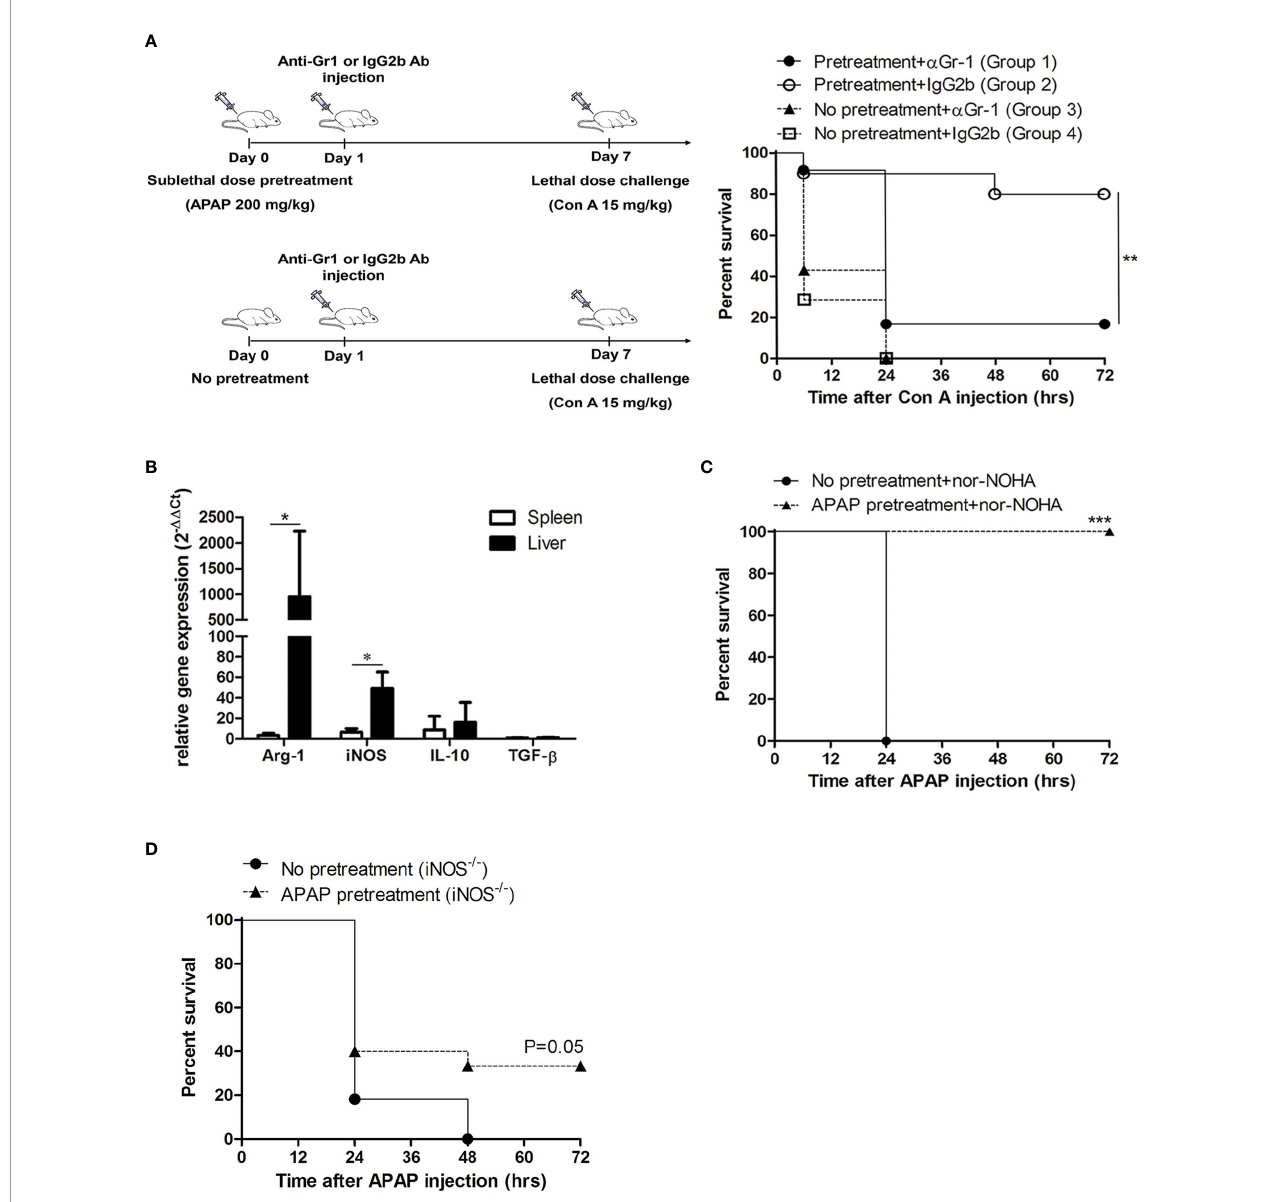
FIGURE 3 | The protective effect induced by acetaminophen (APAP) pretreatment is mediated through myeloid-derived suppressor cell (MDSC) and inducible nitric oxide synthase (iNOS). (A) Mice received sublethal APAP pretreatment on day 0 and were injected intraperitoneally with anti-Gr1 antibody (Group 1) or Rat IgG2b isotype antibody (Group 2) on day 1. On day 7, mice were challenged with a lethal dose of Con A. Group 3 and 4 were mice without sublethal APAP pretreatment, but received anti-Gr1 antibody (Group 3) or Rat IgG2b isotype antibody (Group 4) on day 1. On day 7, mice were challenged with a lethal dose of Con A. The survival curves were plotted (n=12 per group). **P < 0.01, Log-rank test. (B) mRNA expression of CD11b + Gr-1 + cells isolated from the liver and the spleen at 7 days after APAP pretreatment. *P < 0.05, Mann-Whitney test. Data were expressed as mean ± SD. (C) BALB/c mice with or without APAP pretreatment were injected with nor-NOHA before the lethal dose challenge on day 7 and the survival curves were plotted. (No APAP pretreatment group, n=6; APAP pretreatment group, n=12). ***P < 0.001, Log-rank test. (D) iNOS knockout mice with or without APAP pretreatment on day 0 were challenged with a lethal dose of APAP on 7 and the survival curves were plotted. (No APAP pretreatment group, n=11; APAP pretreatment group, n=15). P=0.05, Log-rank